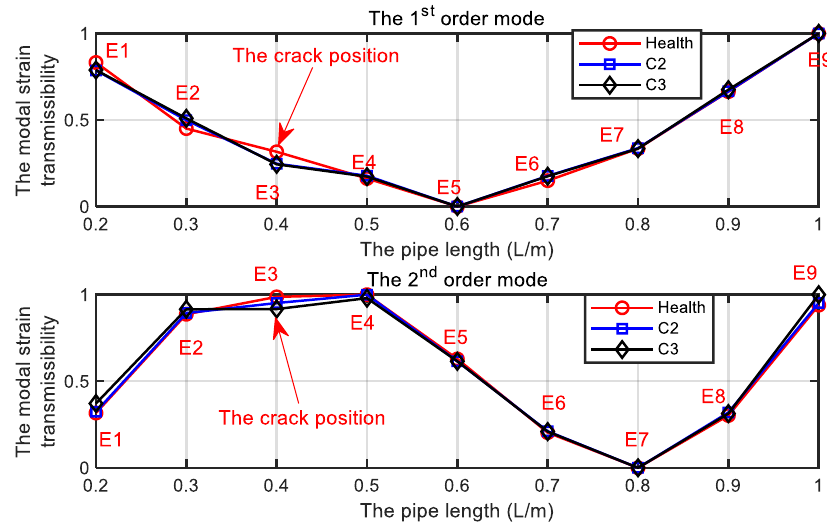
Sensors 2019 , 19 , x FOR PEER REVIEW Figure 11. The first two modal strain transmissibility for the scenarios listed in Table 5.